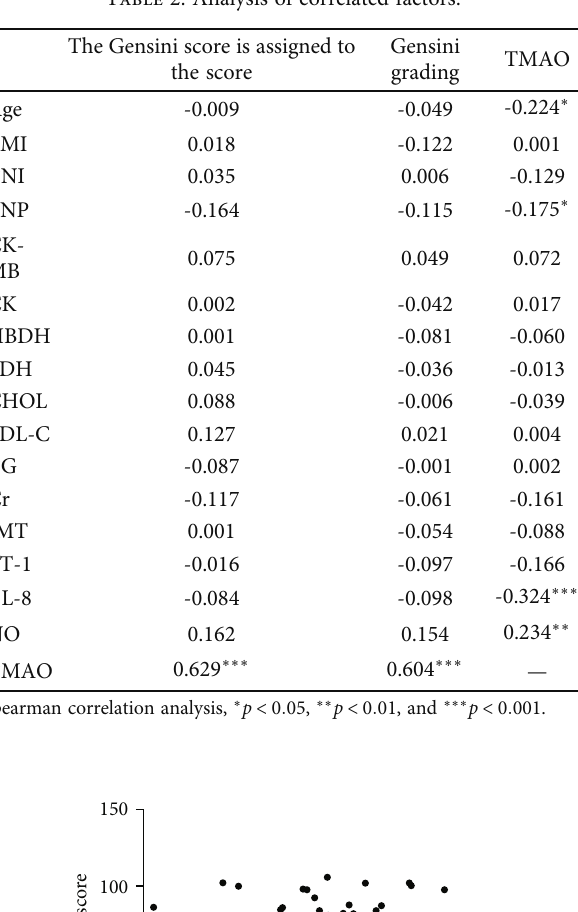
Table 2: Analysis of correlated factors. The Gensini score is assigned to